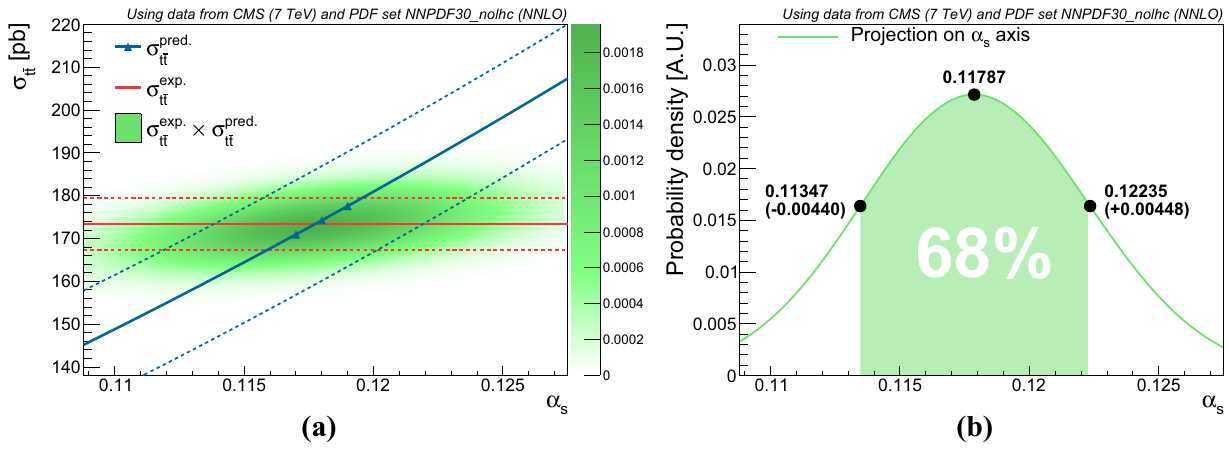
Fig. 2 a The central values and 1 σ deviations for the predicted cross section ( f pred (σ t ¯ t | α s ) , blue oblique lines) and the experimental cross section ( f exp (σ t ¯ t | α s ) , red horizontal lines) and the product of the prob-